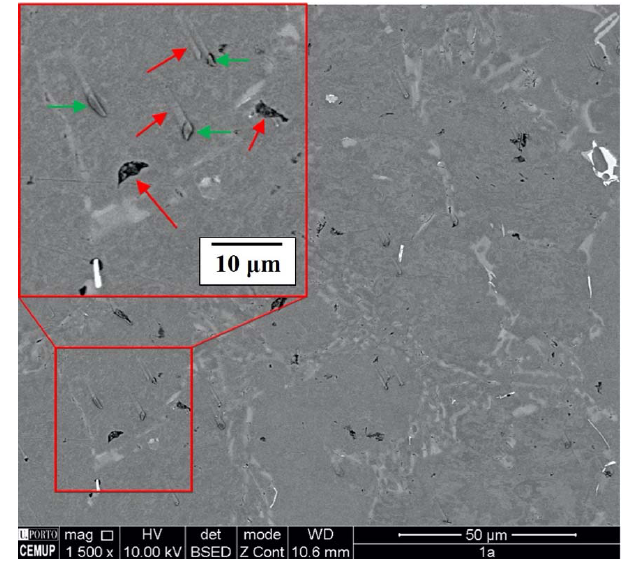
Figure 9. Detail of the scratching of the α -Al matrix by detached m-SiCp (Condition 1-Position 1a).